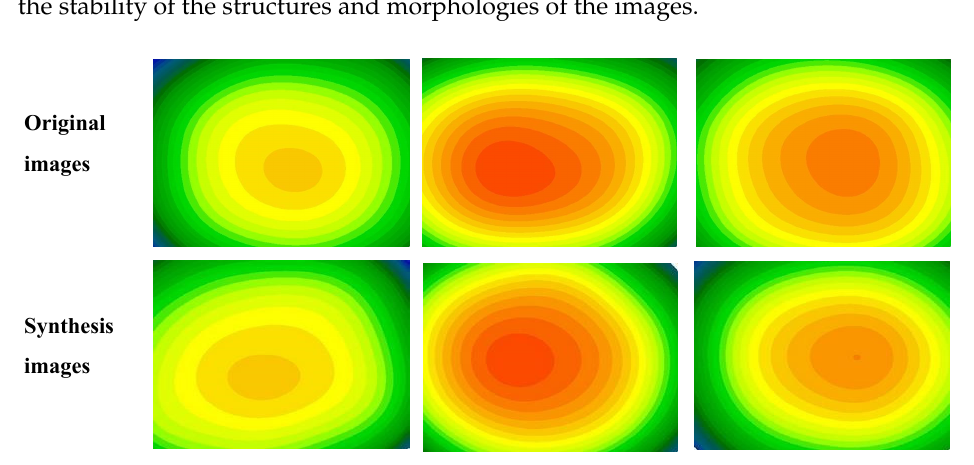
Table 6. Convolutional neural network ( CNN) classifier’s average time test (ATT) (s).